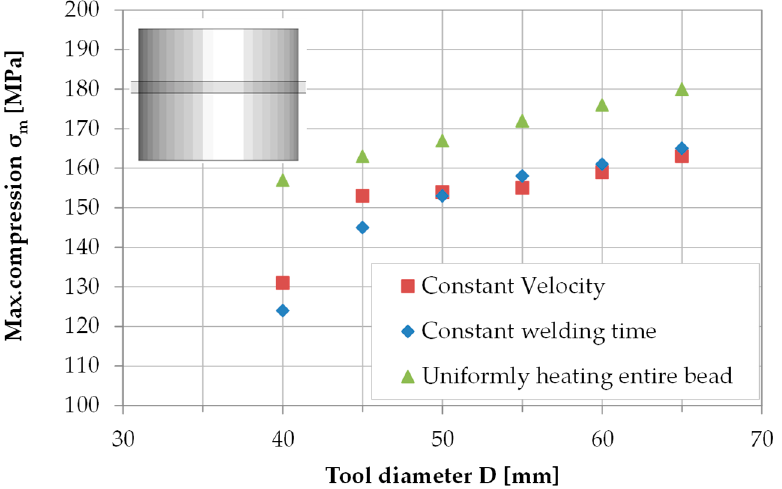
Figure 29. Maximum compressive stresses induced by a bead on the tool surface having different diameters at different operating conditions. diameters at different operating conditions.